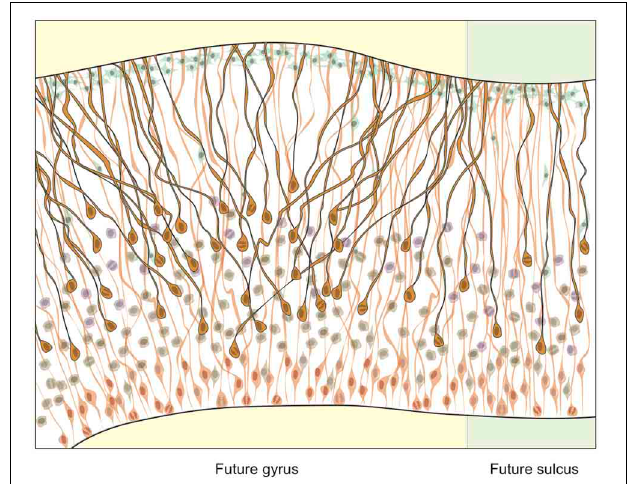
FIGURE 4 | Basal fibers extending to the cortex during development. The density of progenitors in the proliferative basal compartment is increased and the angle of migration of their fibers more oblique at sites of developing gyri compared to sulci. In lissencephalic species, the basal compartment is scarcely populated by proliferating progenitors and fibers migrate in parallel to the developing